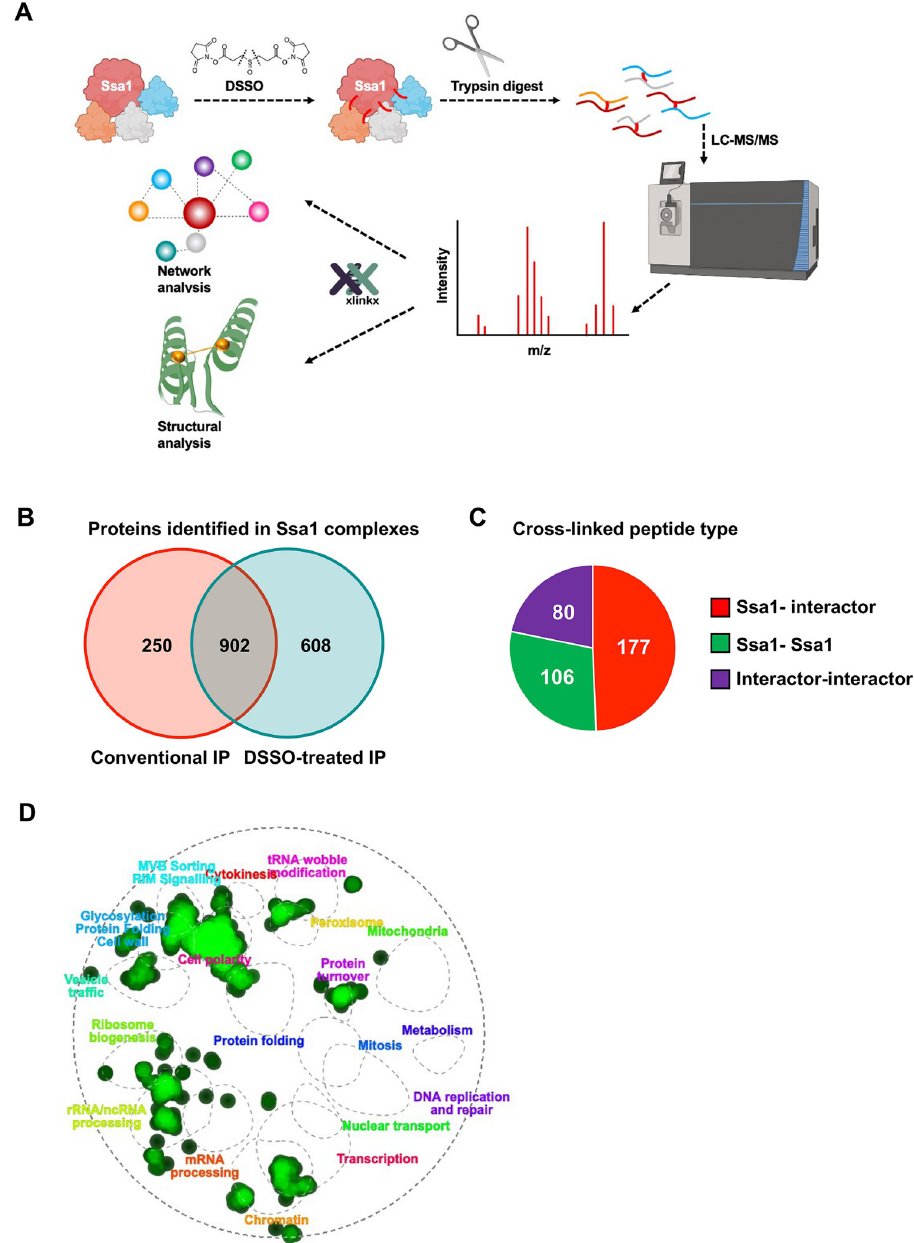
Fig 1. Cross-linking mass spectrometry of Ssa1 complexes. (A) Experimental workflow of cross-linking mass spectrometry of Ssa1 complexes purified from yeast cells. HIS-Ssa1 complexes were cross-linked with DSSO, purified from yeast, digested into peptides via trypsin, and analyzed by mass spectrometry. Created with BioRender.com. (B) Venn diagram representing Ssa1 complexes found in conventional IP and DSSO-treated IP. (C) Pie chart showing types of cross links identified from XL-MS analysis. (D) GO analysis of DSSO-treated Ssa1 immunoprecipitated complexes and cross-linked Ssa1 complexes using TheCellMap.org. DSSO, disuccinimidyl sulfoxide; GO, Gene Ontology; XL-MS, cross-linking mass